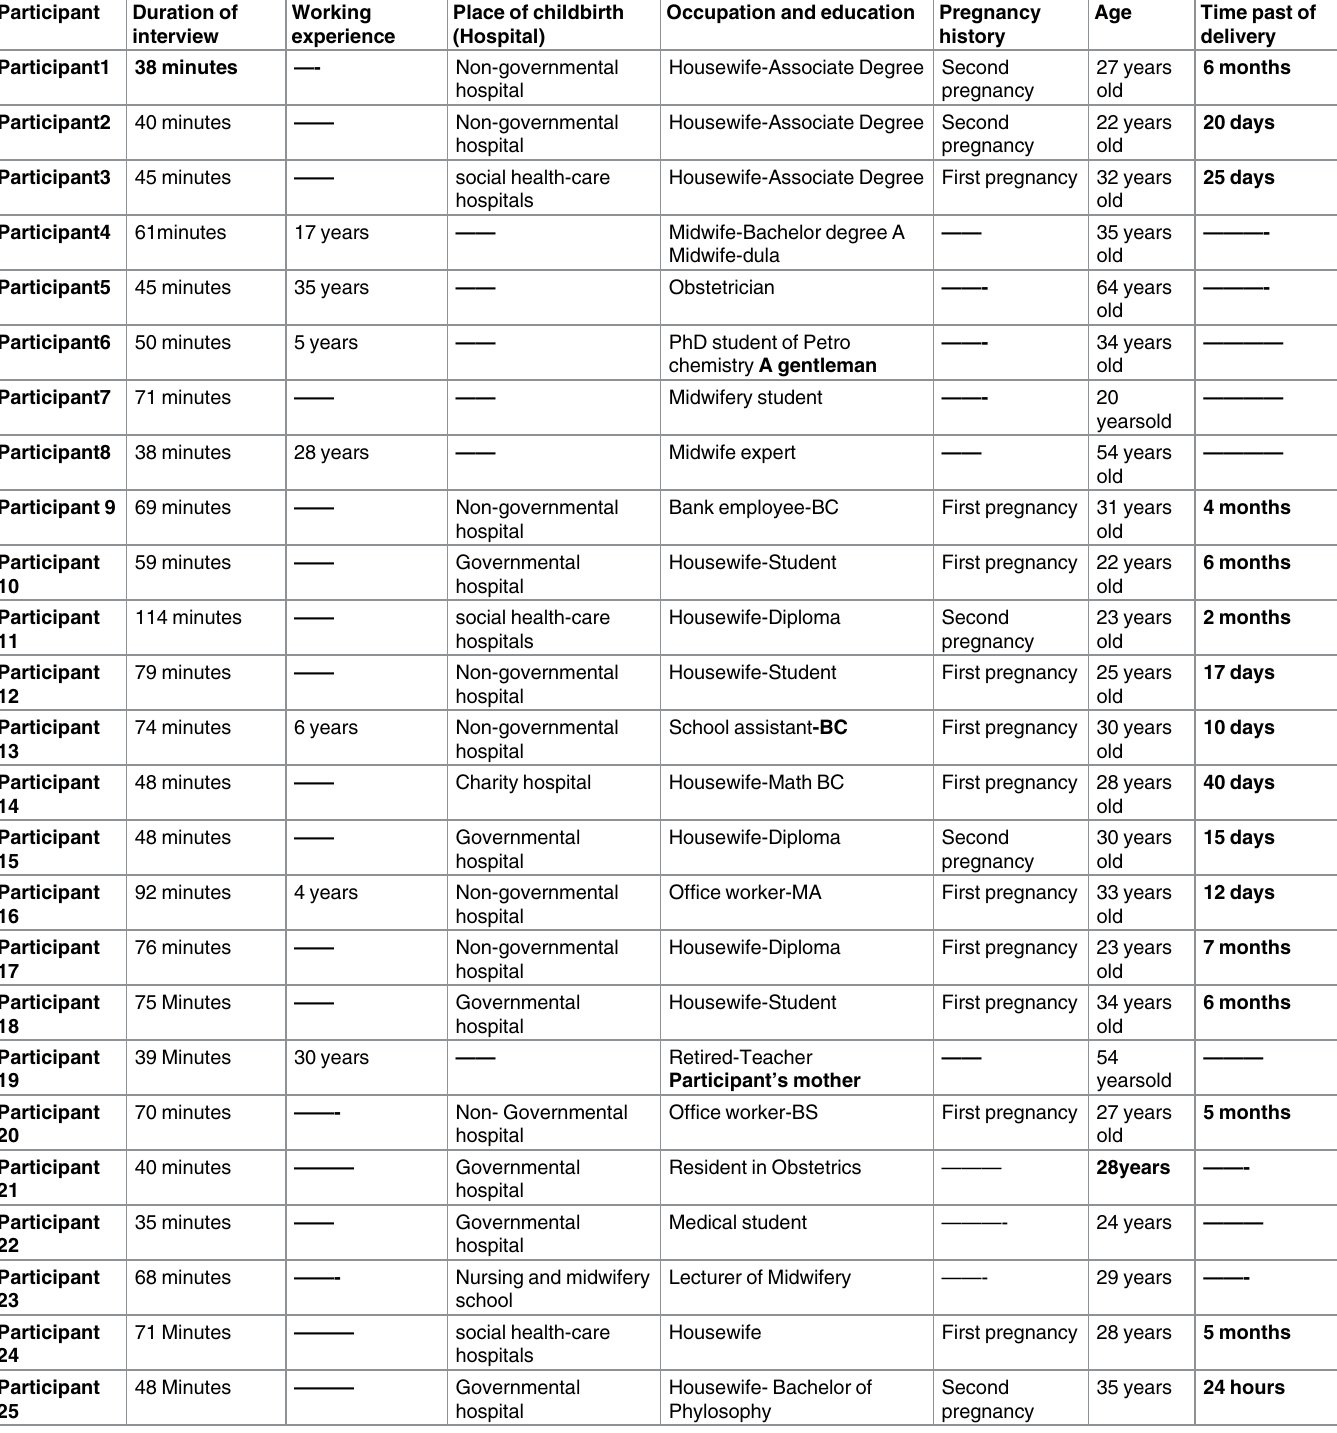
Table 1. Characteristics of the